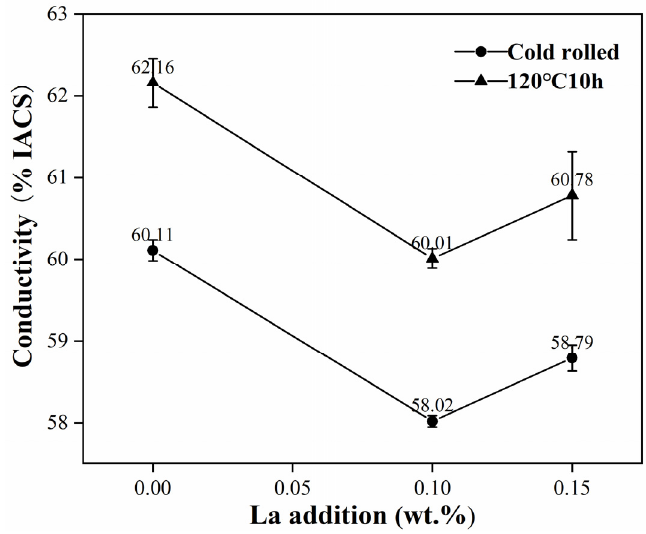
Figure 3. Conductivity of the foil alloys with different La content.